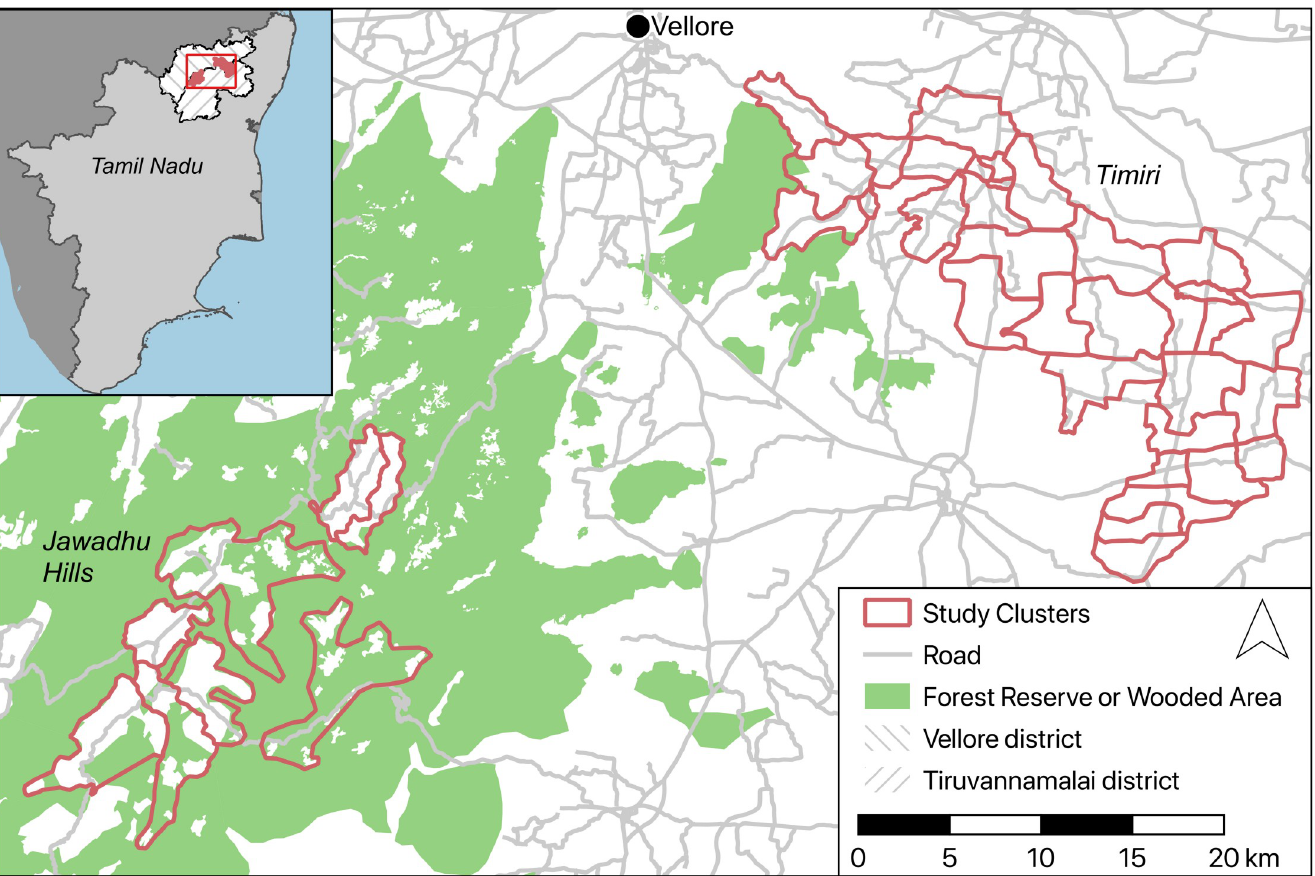
Fig 1. Map of the Deworm3 India trial sub-sites at Timiri (32 clusters) and Jawadhu Hills (8 clusters) in Vellore and Thiruvanamalai districts � of Tamil Nadu (inset). � District administrative boundaries obtained from gadm.org (https://gadm.org/license.html) and map data obtained from OpenStreetMap (https://www.